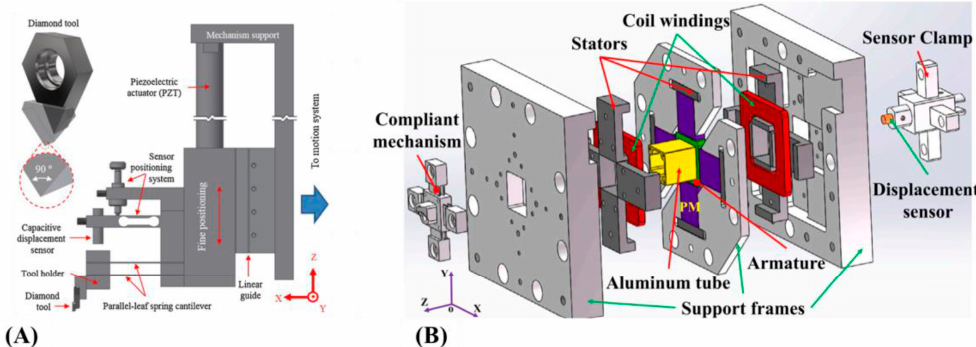
Figure 20. ( A ) AFM inspired design [136]; ( B ) Dual compliant unit design [137].